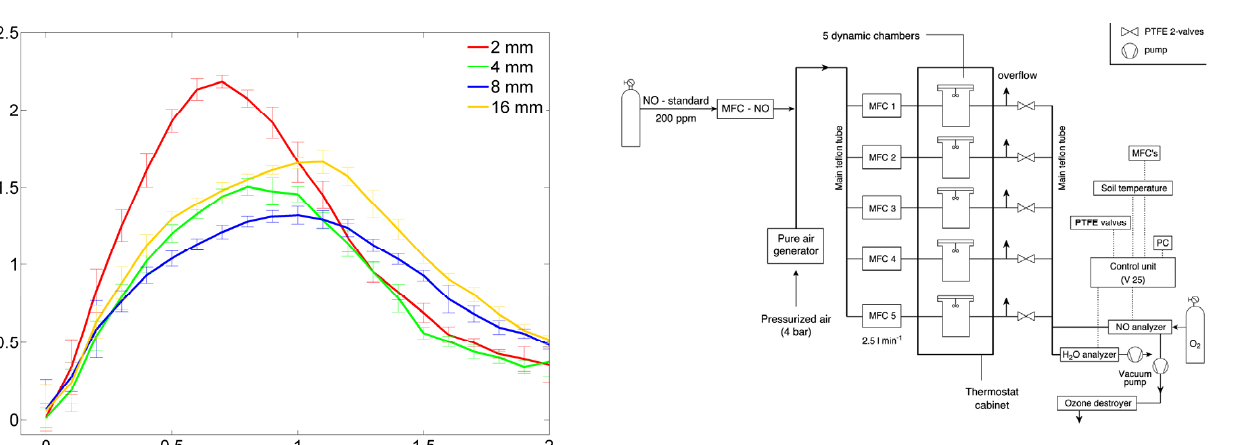
Figure 2. Experimental setup for laboratory investigation of net NO release rates on soil Fig. 2. Experimental setup for laboratory investigation of net NO samples (details, see section 2.4). release rates on soil samples (details, see Sect.